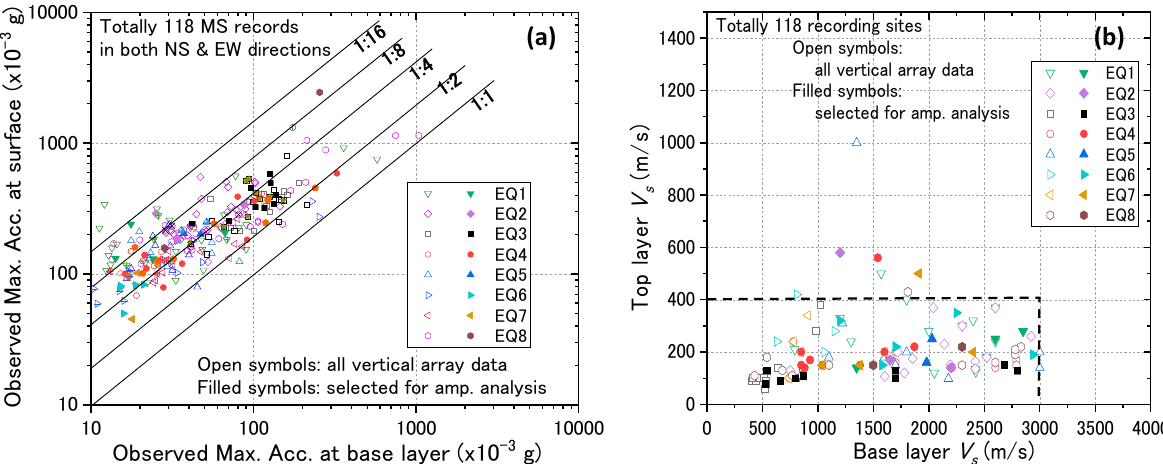
Figure 6. Vertical array data initially addressed: observed maximum accelerations at surface versus those at base layer ( a ), S-wave velocities V s at top layers versus those at base layers ( b ).